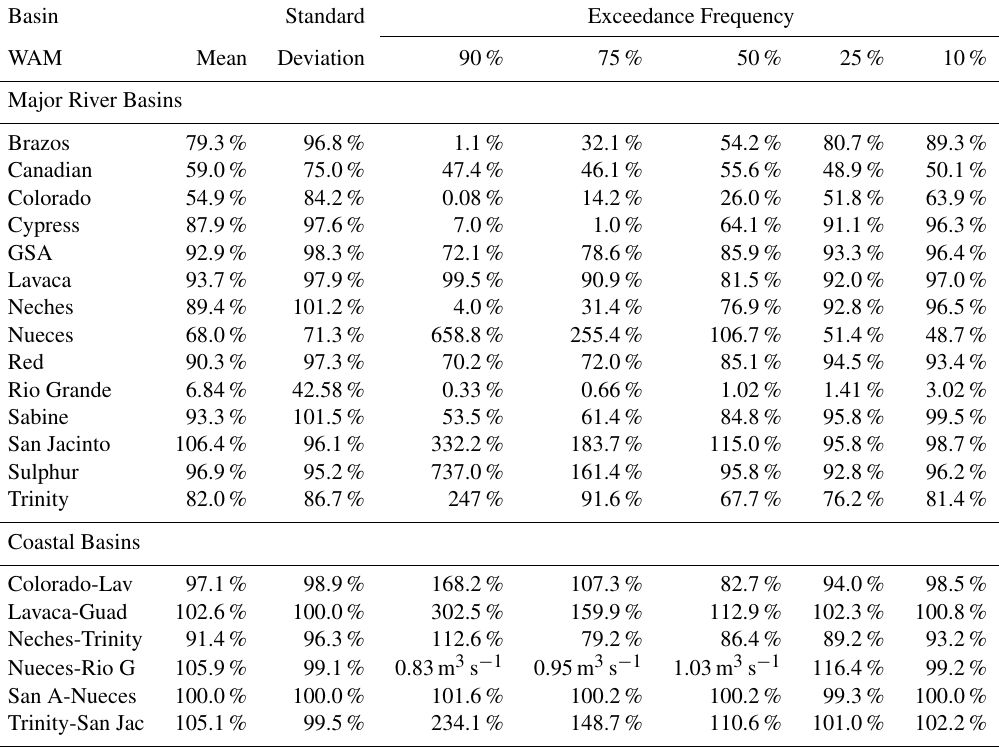
Table 5. Frequency metrics for regulated flows at basin outlets as a percent of naturalized flows. Basin